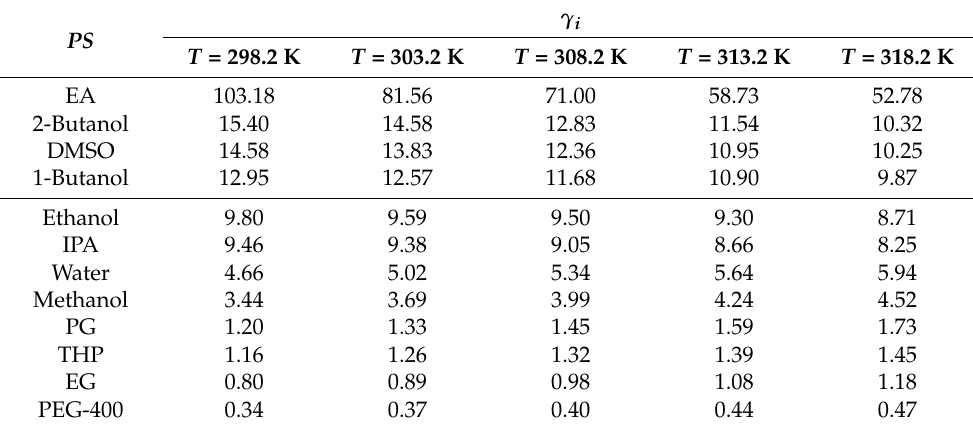
Table 4. Activity coefficients ( γ i ) of ECT in various PS at T = 298.2 K to 318.2